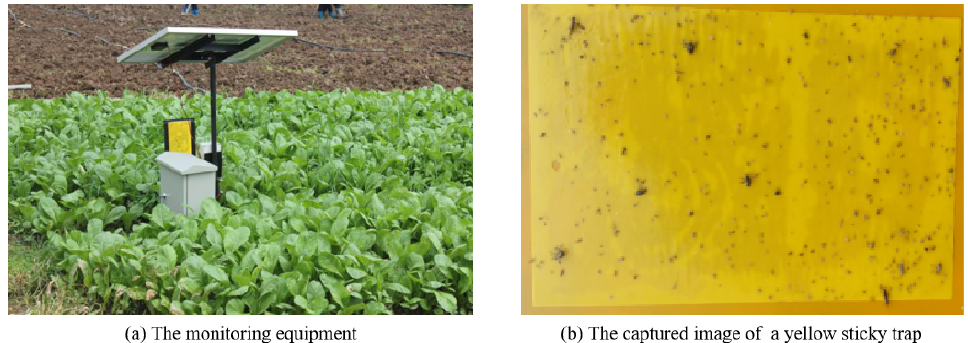
Figure 1. Illustration of ( a ) the monitoring equipment and ( b ) the captured image of a yellow sticky